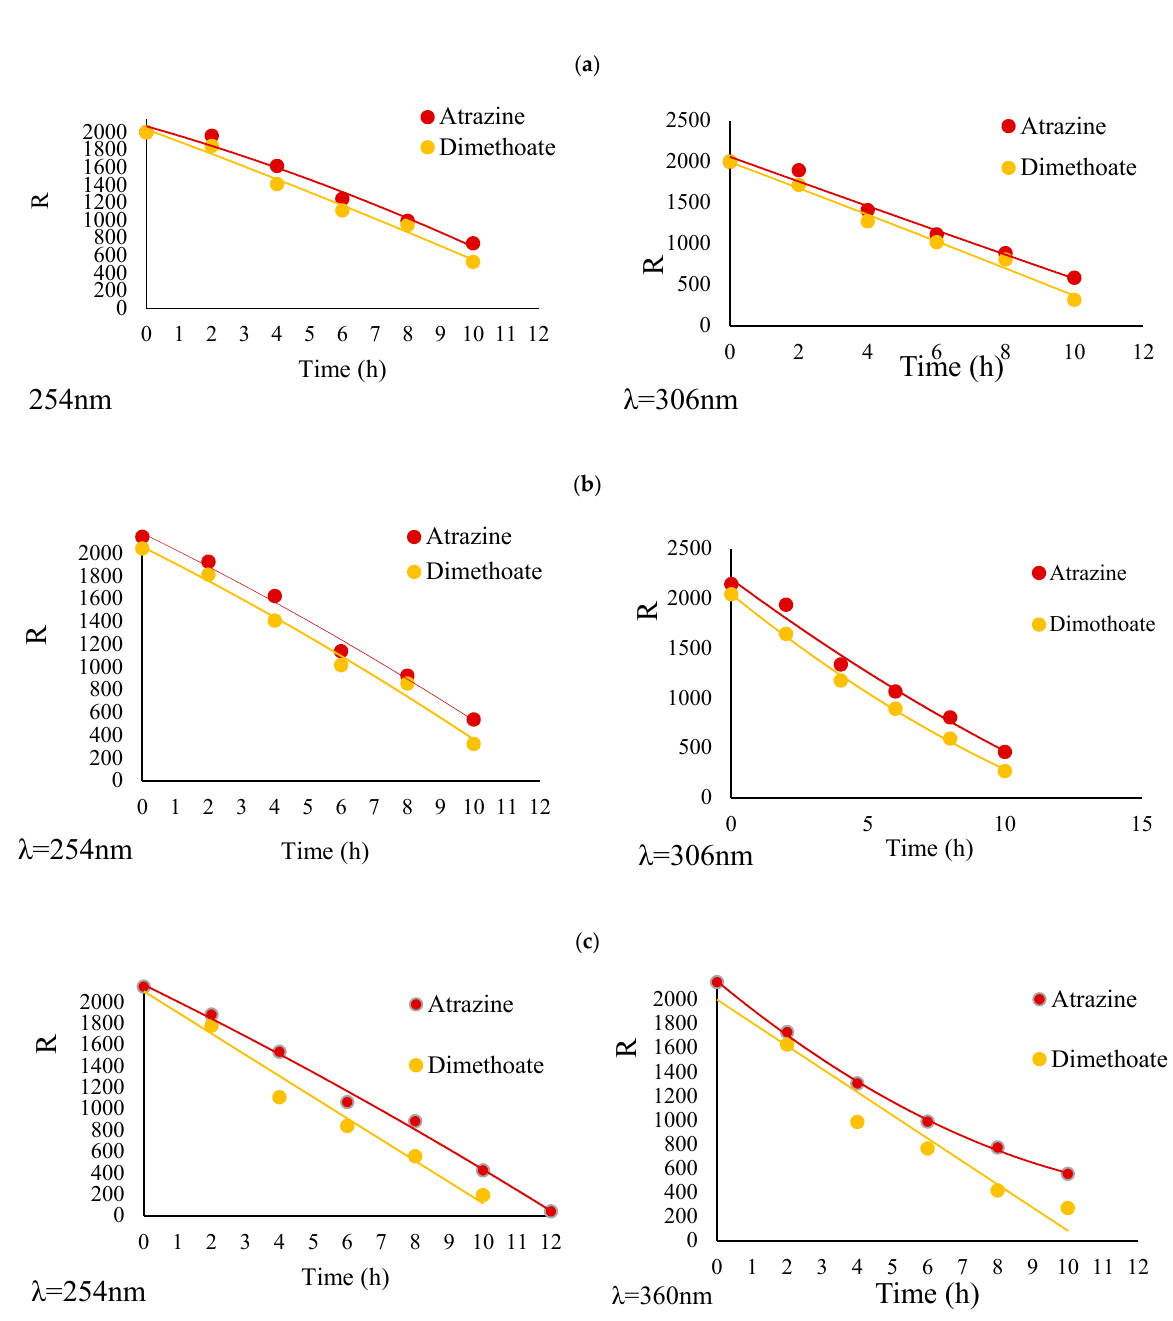
Figure 2. Concentration of pesticides (R(ppb)) as a function of exposure time of irradiation for photocatalysis process of pesticides (catalyst is TiO 2 ); ( a ) AS, ( b ) WW, and ( c ) Ag.W.